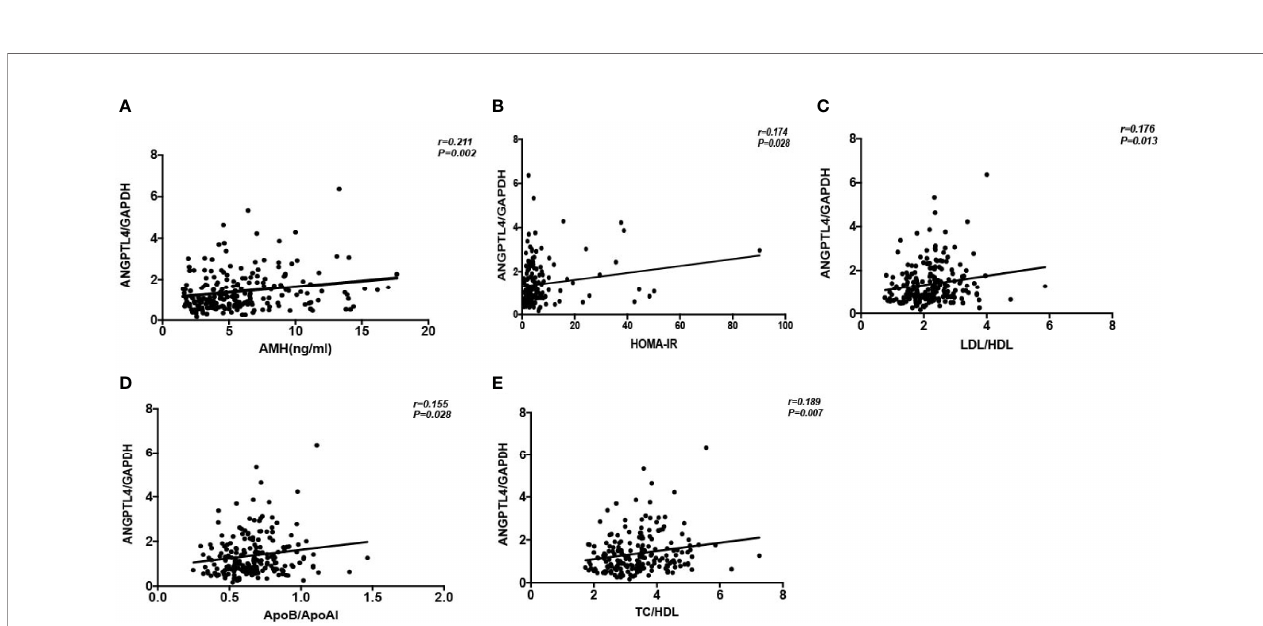
FIGURE 2 | The relative expression of ANGPTL4 in ovarian granulosa cells in subgroups of PCOS and control patients. Data were normalized to GAPDH. "ns" means "no signi fi cance".